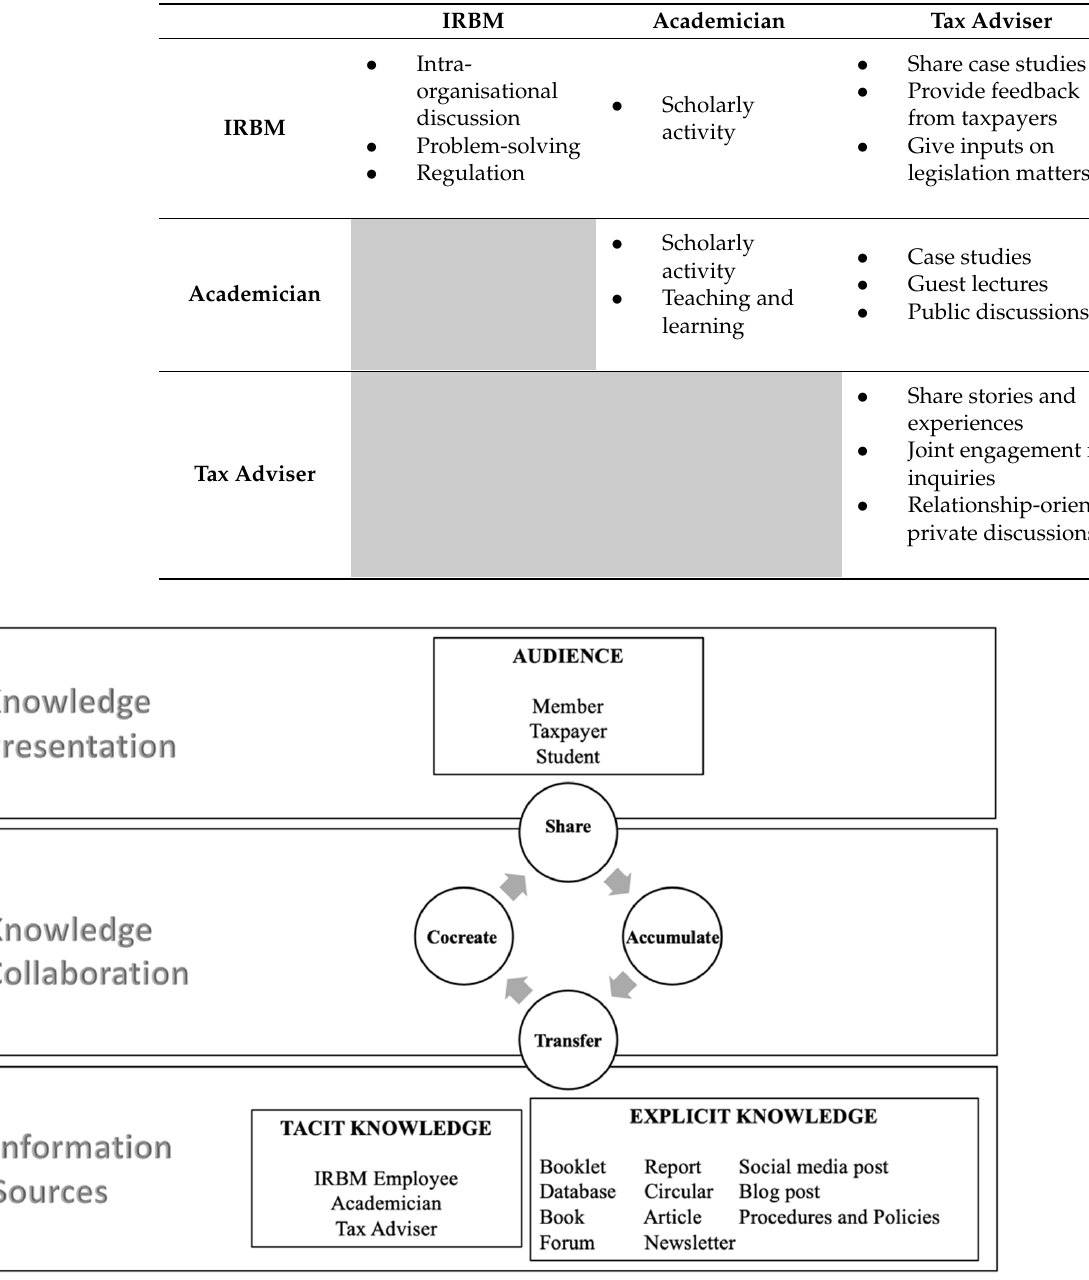
Figure 4. Three-layer